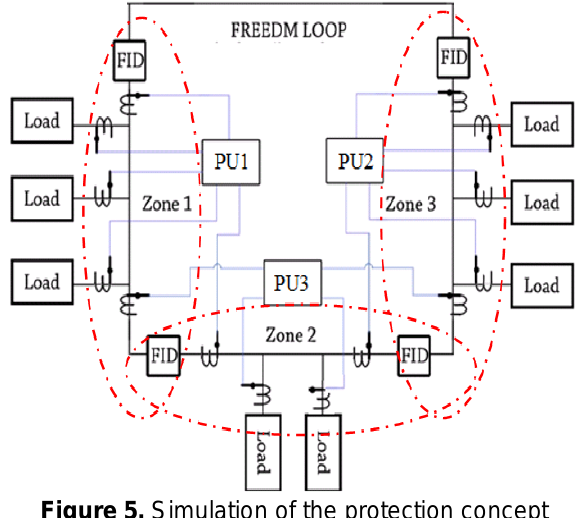
Figure 5. Simulation of the protection concept